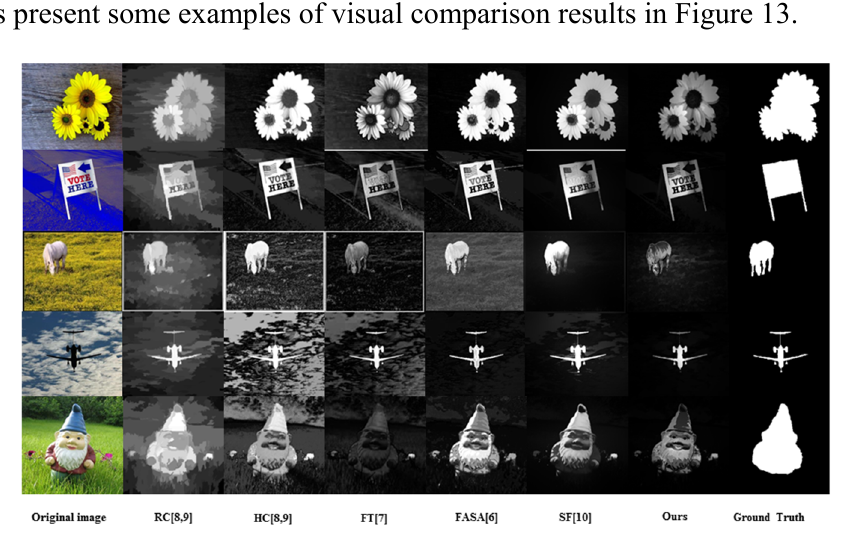
Figure 13. Visual comparison of the six methods on the MSRA-1000